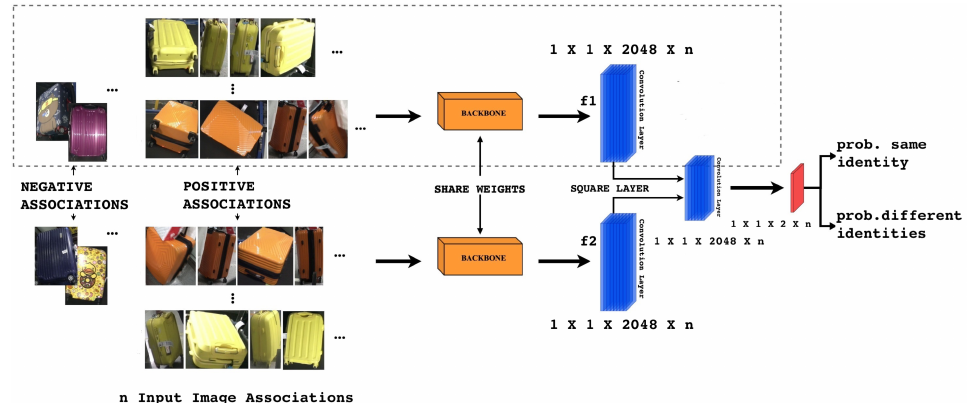
Figure 2. The proposed system. Given n groups of suitcase image associations, two identical Backbone models are used as the non-linear embedding functions and output 2048-dim embeddings f1, f2. Then, f1 and f2 are used to predict the identity of the input suitcase. We introduce a non-parametric layer, called Square Layer, to compare high level features f1 and f2. Finally, the softmax loss is applied on the